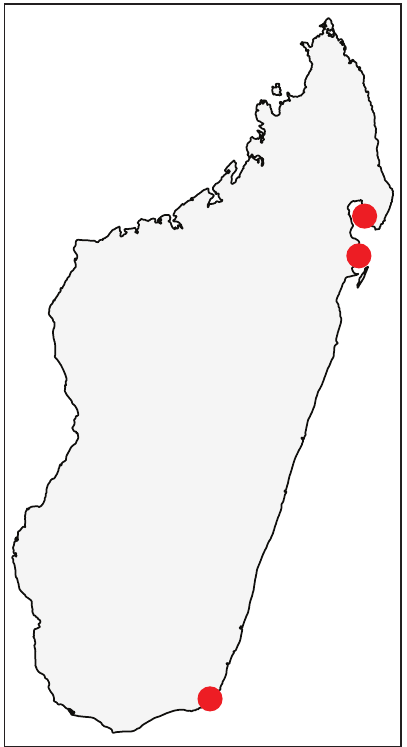
Figure 25. Geographic distribution of Nesomyrmex edentatus sp. n.. The known localities of N. edentatus sp. n. in